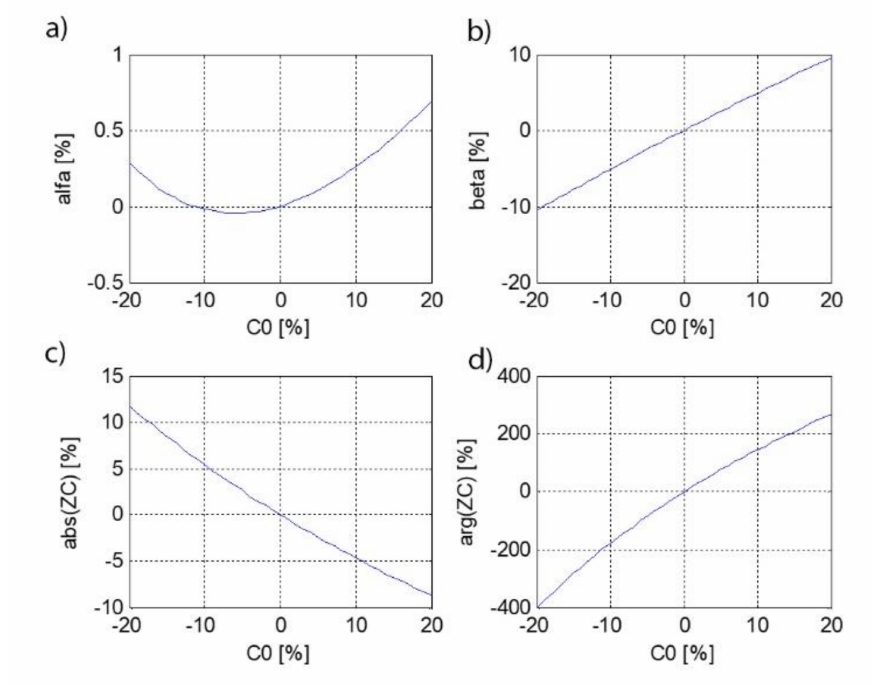
Figure 9. Changes of wave parameters depending on C 0 at f = 500 kHz; ( a ) damping factor α ,